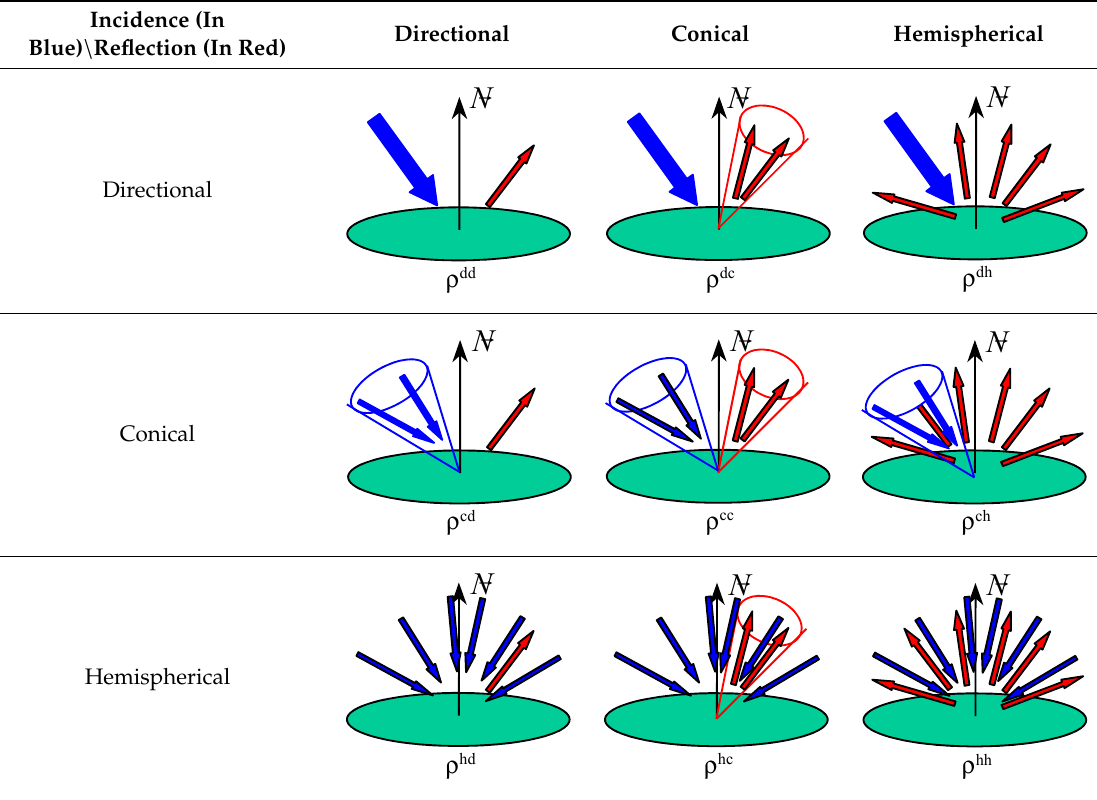
Table 1. Illustration of various kinds of reflectance (extracted from [8]). Incidence (in blue) \ Reflection (in red)